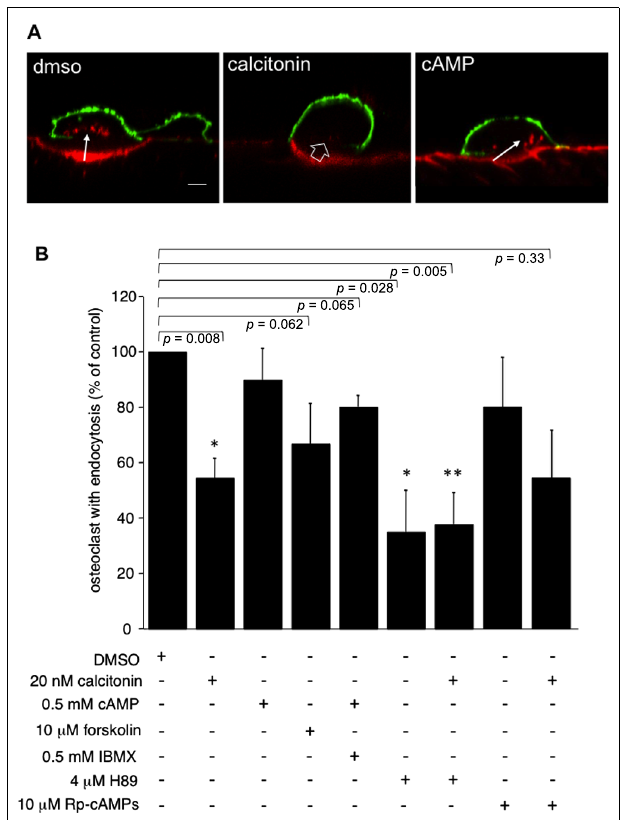
FIGURE 1 | Incubation of osteoclasts with 20 nM calcitonin for 30 min reduces endocytosis in osteoclasts. This effect is only partially mimicked by addition of forskolin to directly activate adenylate cyclase, or by raising intracellular cAMP with 6-MB-cAMP (cAMP) alone or together with the phosphodiesterase inhibitor IBMX. Inhibiting signaling pathways downstream of cAMP does not reverse the calcitonin effect. Exposure of osteoclasts to 4 μ M of the PKA inhibitor H89 for 30 min lowers the number of endocytosis-active osteoclasts to a level comparable to calcitonin addition. Incubation of the cells with H89 for 5 min before the addition of calcitonin does not reverse the calcitonin-mediated inhibition of endocytosis.The inhibitory analog of cAMP, Rp-cAMPS, has only limited effects on endocytosis on its own and does not reverse the response to calcitonin. (A) Lateral view of rabbit osteoclasts plated on dentine after incubation with vehicle, calcitonin or 6-MB-cAMP for 30 min. Red, TRITC-dextran; arrow, endocytosedTRITC-dextran; open arrow, ruffled border area without endocytosis; green, anti- α v β 3 antibodies. Scale bar: 10 μ m. (B) Chart showing the inhibitory effect of the different drugs when compared to endocytosis in vehicle-treated cells. Results are average of three independent experiments. Error bars represent standard deviation, significant reductions in dextran endocytosis compared to control are marked: * p < 0.05, ** p < 0.005, individual p -values are shown above the bars.